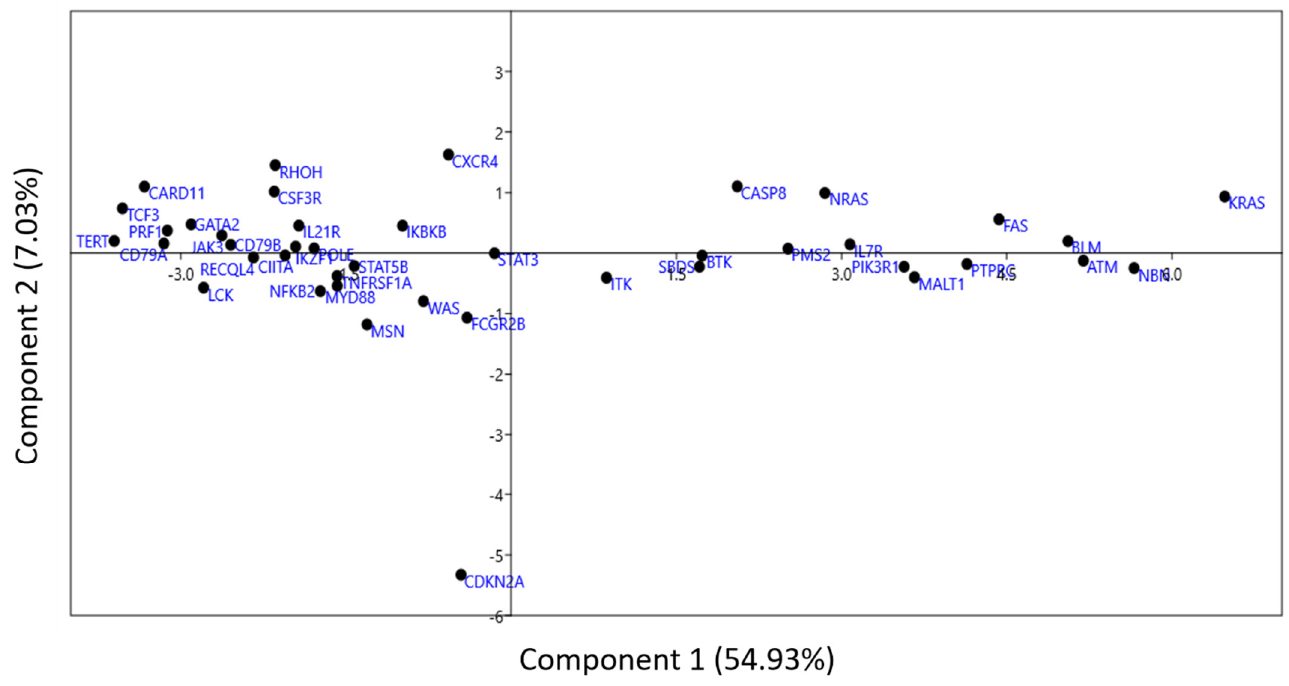
Figure 7. Mirror image plot depicting the correlation between RSCU values with gene expression and CUB. A bigger-sized eclipse described a higher Pearson’s correlation coefficient (r) value, and vice versa. The red colored circles show a positive correlation, whilst blue circles indicate a negative correlation. Crossed boxes show an insignificant correlation.